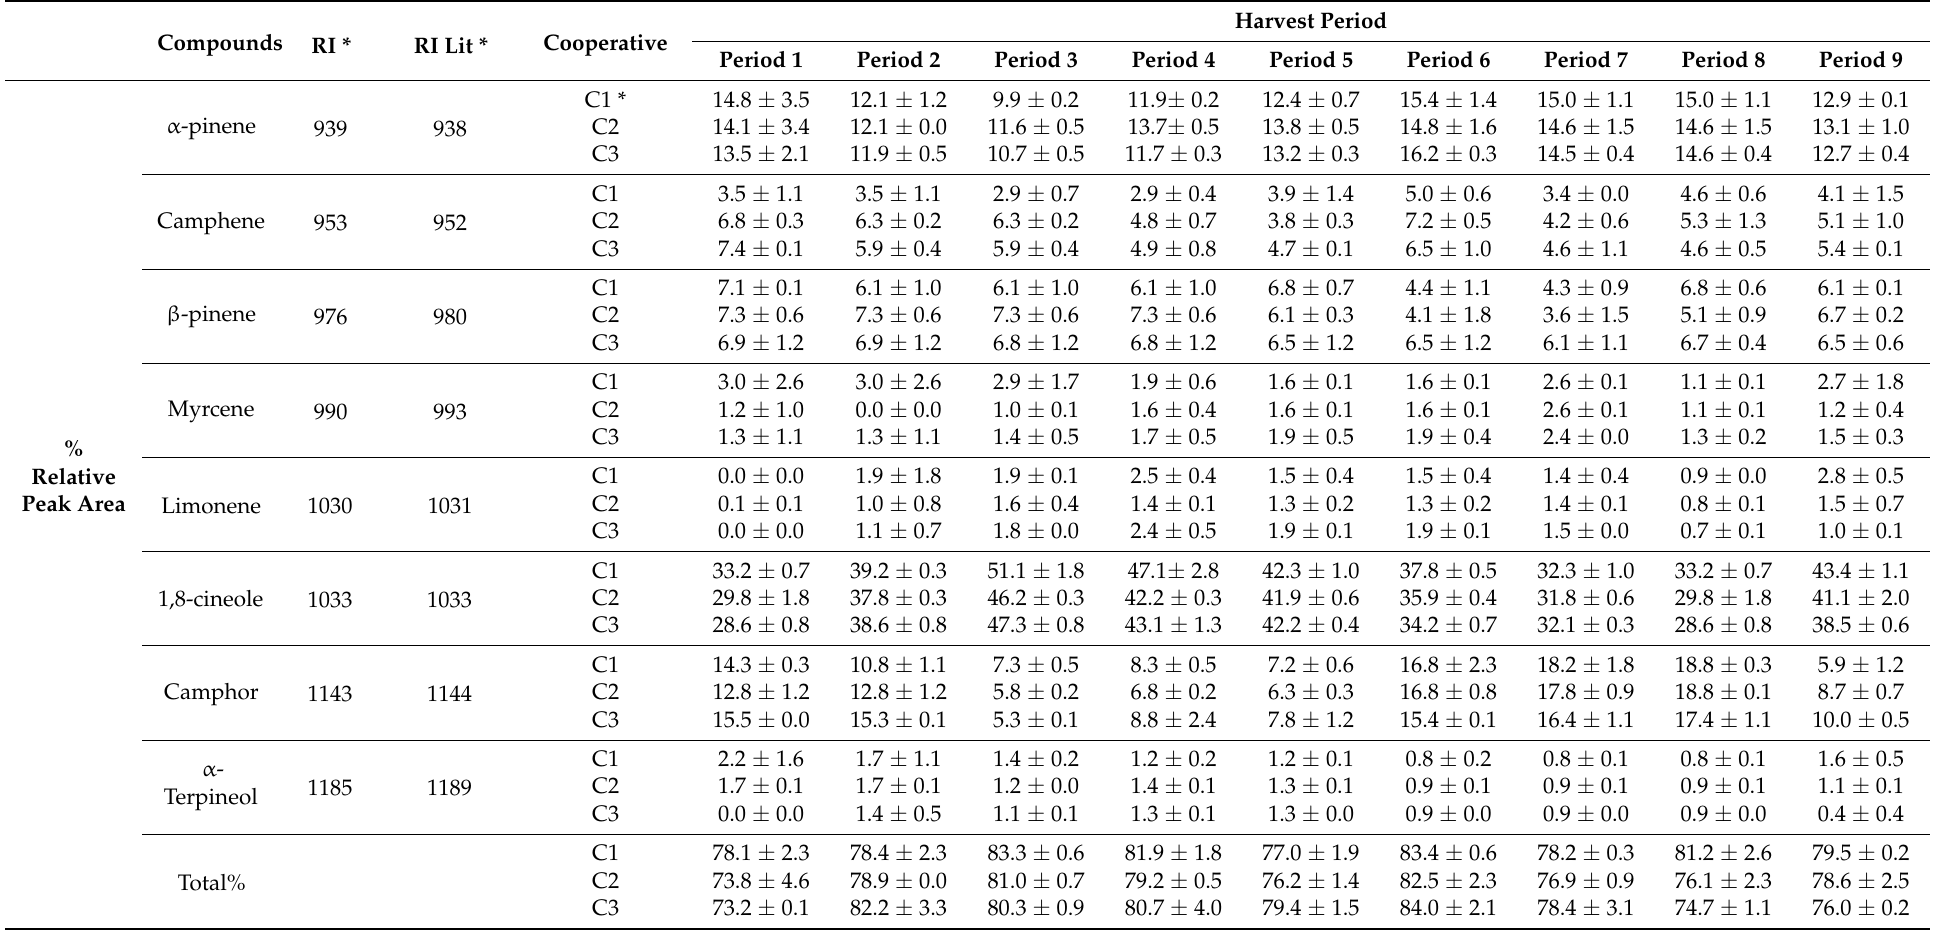
Table 1. Major components of the chemical composition of S. rosmarinus essential oils from each cooperative and harvest